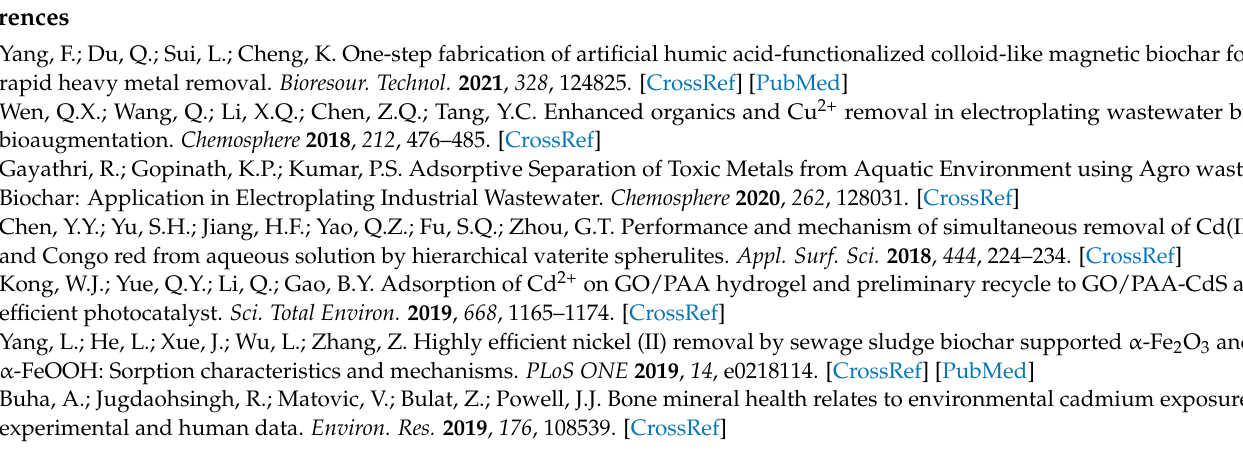
removal. Figure S1: Effect of preparation temperature on the Cd 2+ and Cu 2+ removal by SB and SB- NZVI composites, Figure S2: Effect of (a) different Cu 2+ initial concentration on the removal of Cd 2+ and (b) different Cd 2+ initial concentration on the removal of Cu 2+ by SB-NZVI(1:4-900), Figure S3: XPS Wide-scan spectra of SB-NZVI(1:4-900) and after reaction with Cd 2+ , Cu 2+ and coexisting Cd 2+ and Cu 2+